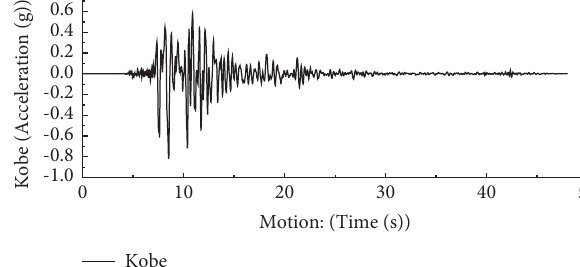
Figure 3: Acceleration time history of Kobe motion.